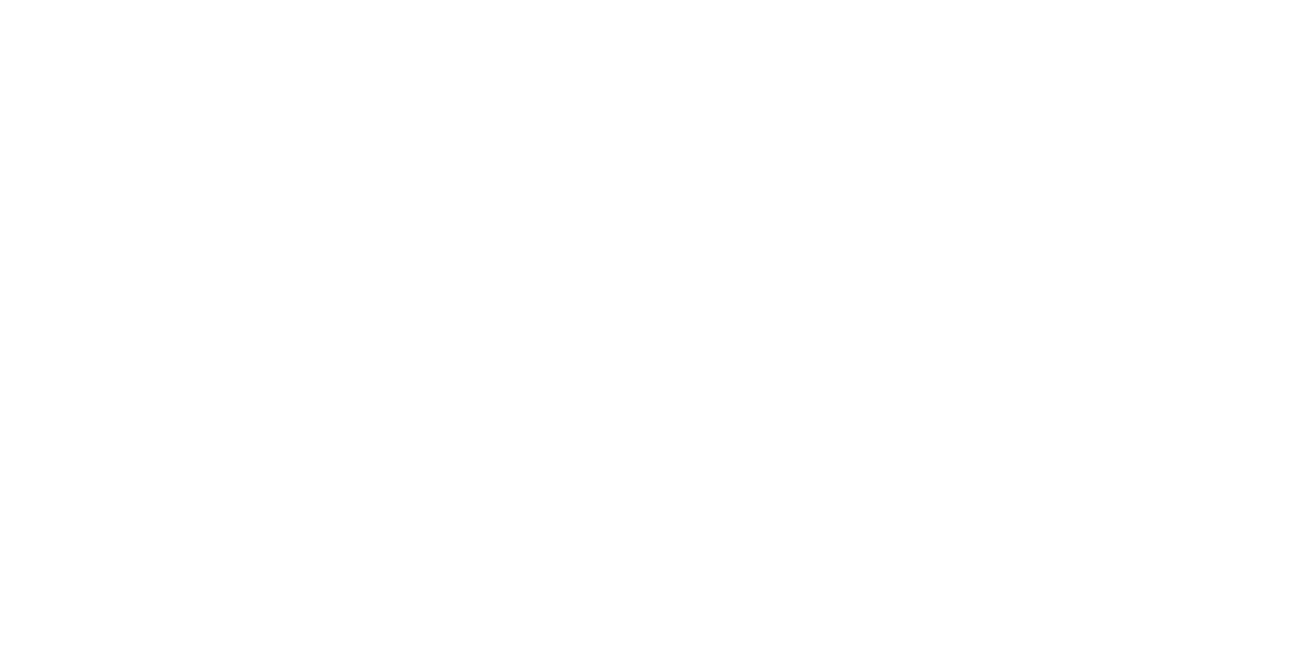
Frontiers in Neurology |